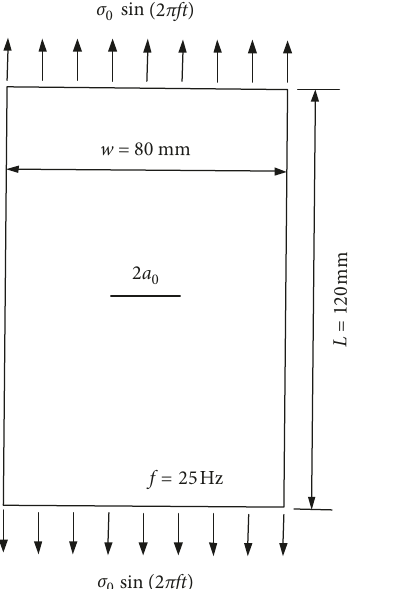
Figure 16: Center cracked plate subjected to imposed sinusoidal stress.